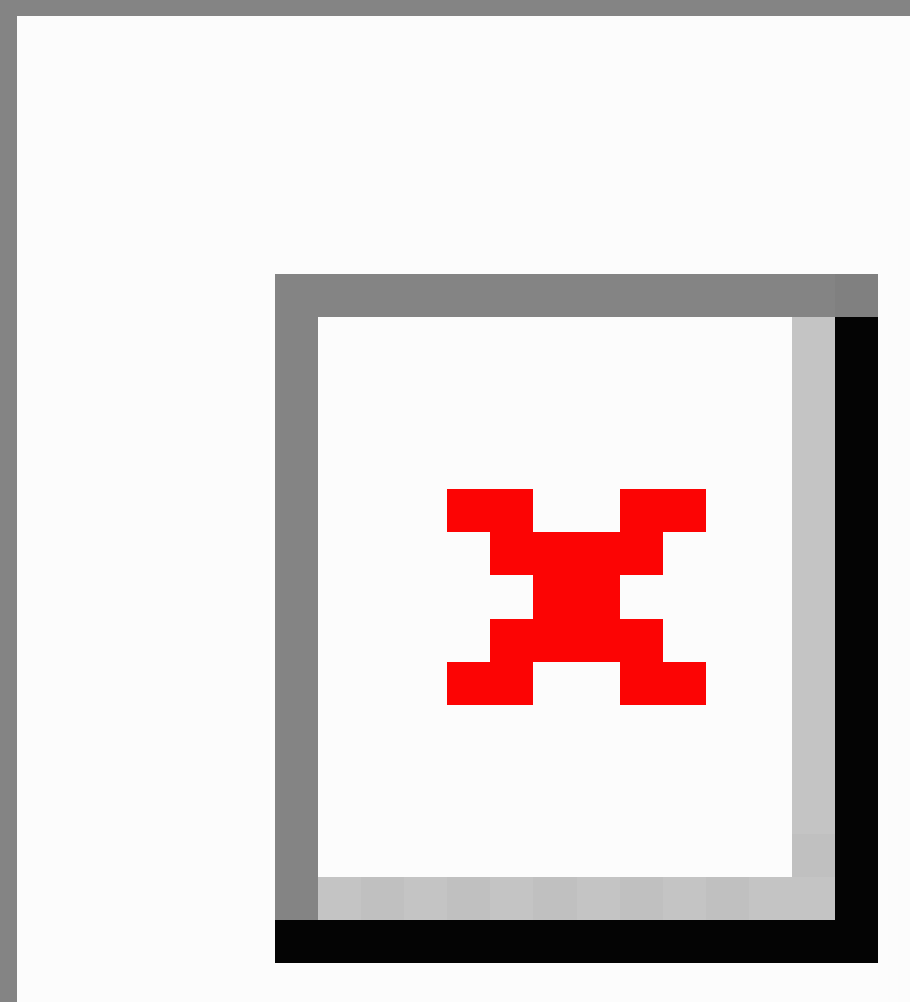
Figure 3. Screenshot of mammography views in the e-learning